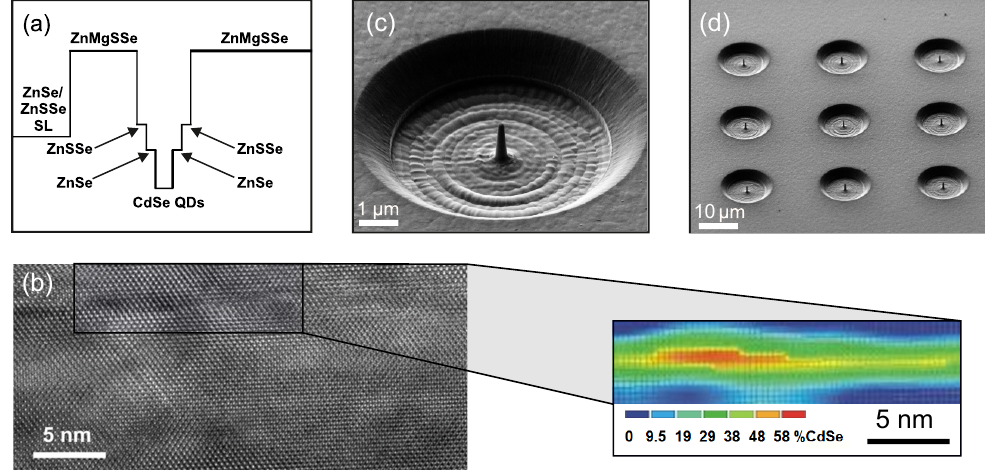
Figure 3. ( a ) Energy-band diagram of a CdSe QD confined between wide-gap barriers. ( b ) Cross- section high-resolution transmission electron microscopy (HRTEM) image of a heterostructure with CdSe QDs (darker spots). Inset shows Cd distribution obtained from the analysis of the contrast of a HRTEM image. ( c , d ) Scanning electron microscopy images of typical devices recorded at different